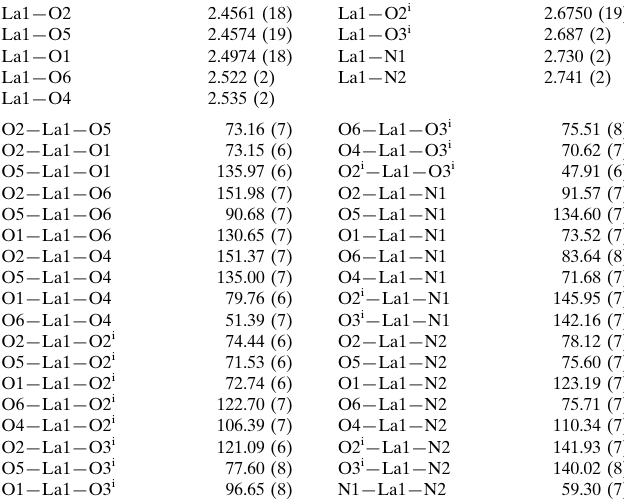
Selected geometric parameters (A˚ , (cid:2)